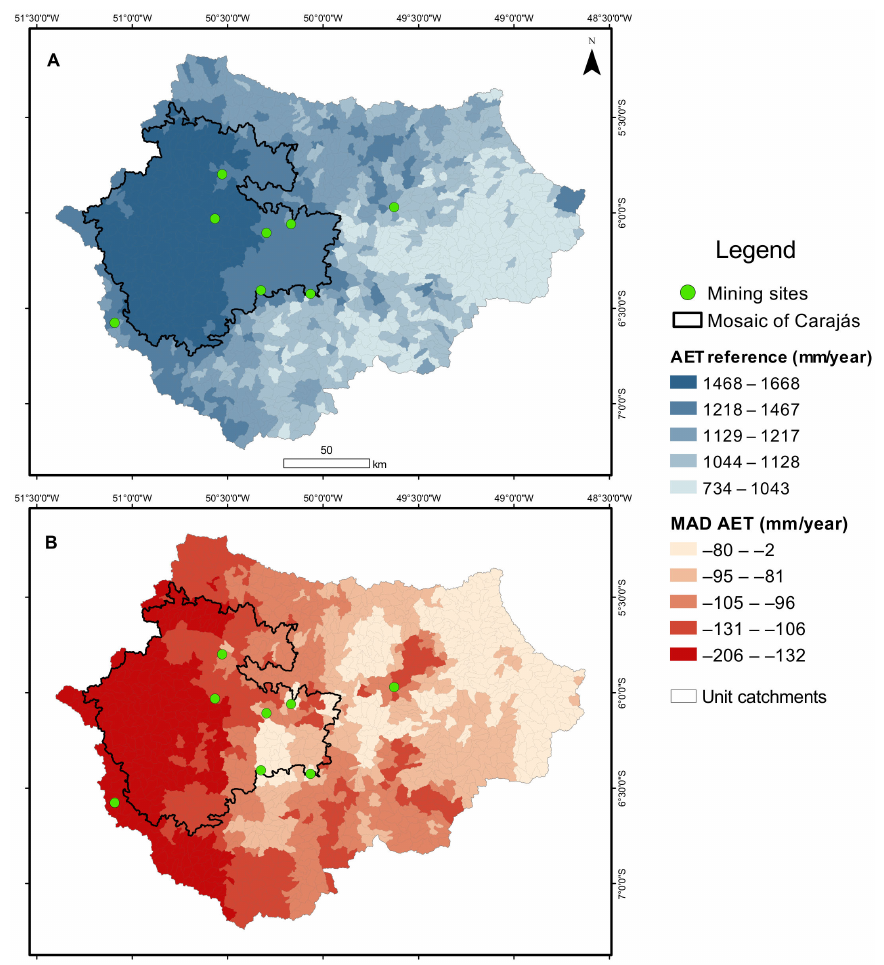
Figure 10. ( A ) Annual average actual evapotranspiration AET (mm/year) for the reference period; and ( B ) mean absolute differences (mm/year) of annual average AET between the future (mGCMs) and reference periods for the RCP8.5 scenario (we decided not to show the results of RCP4.5 because the results showed similar spatial